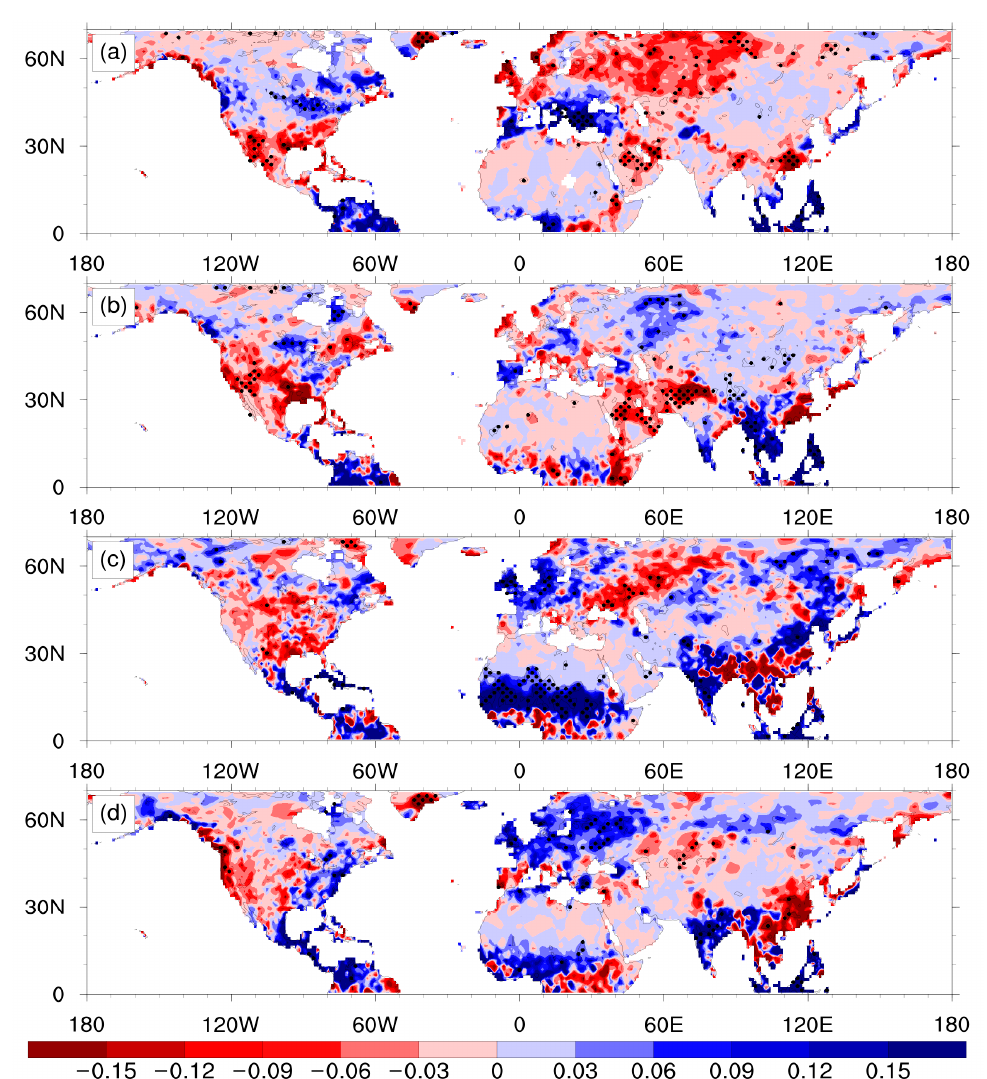
Figure 1. Spatial distributions of the leading empirical orthogonal function (EOF) of the decadal-to-multidecadal variability of land precipitation from the Global Precipitation Climatology Centre (GPCC) in the northern hemisphere in ( a ) winter, ( b ) spring, ( c ) summer, and ( d ) autumn. Dotted regions indicate exceeding 95% significance t -test. Unit: mm/day.